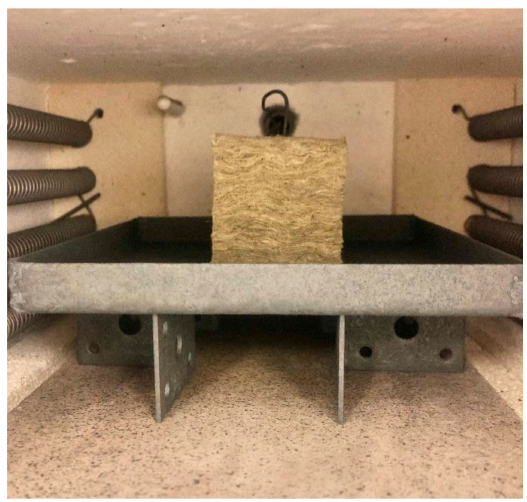
Figure 3. Test setup in the mu ffl e oven.